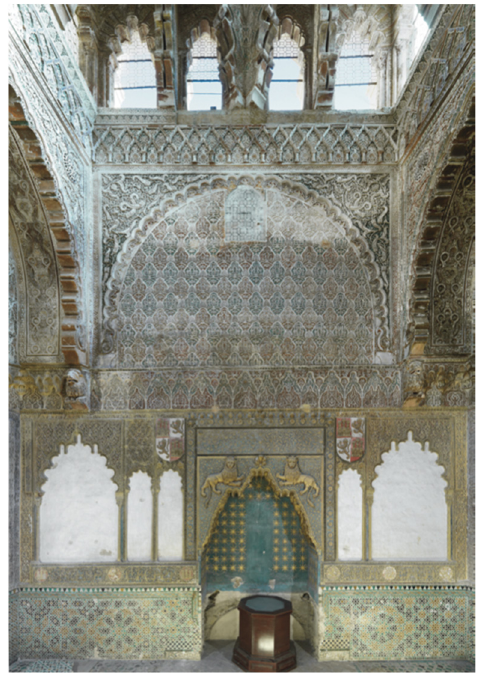
Figure 2. Royal Chapel’s East wall. 1371. Mosque/Cathedral of Córdoba.